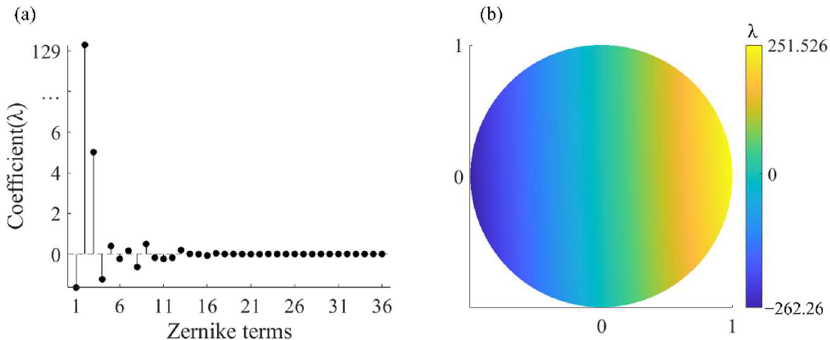
Figure 13. ( a ) Zernike coefficient of image plane wavefront. ( b ) Image plane